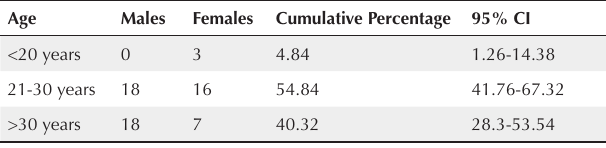
Table 1. Clinicodemographic profile of patients of Wilderness/Backcountry diarrhea (n =